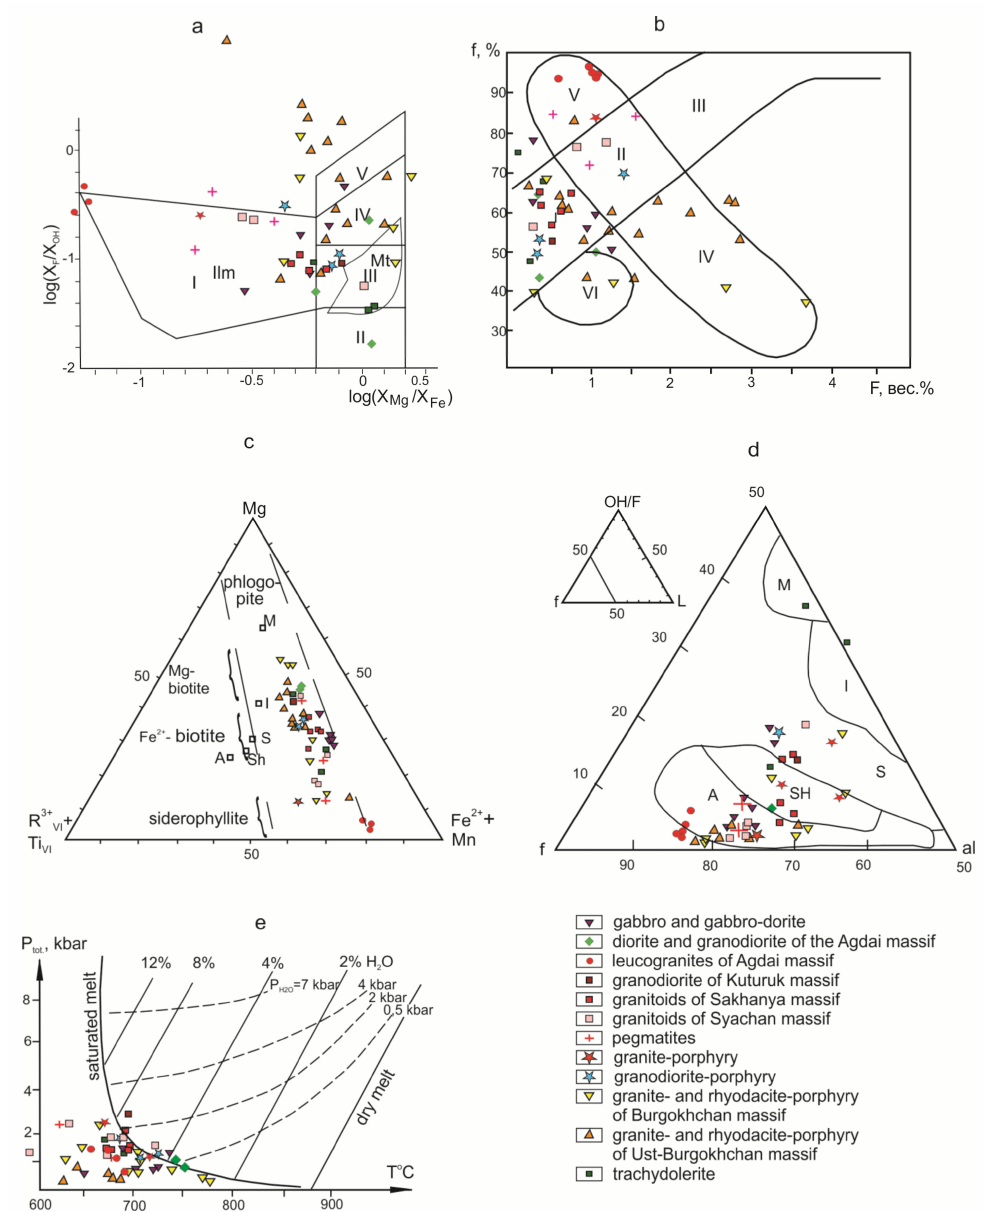
Figure 4. Composition of biotites from magmatic rocks of the Selennyakh River basin: ( a ) F/OH– Mg/Fe diagram for biotites of magmatic rocks. Fields of biotite derived from melts [28]: I— contaminated and assimilated marine metasediments; II—mantle; III—crustal-mantle; IV—mantle- crustal; V—crustal anatectic; Ilm—ilmenite series of granitoids, Mt—magnetite series of grani- toids; ( b ) F vs. f diagram for biotites. Fields of the diagram [29]: I–II–III—biotites from rocks of granite-leucogranite and granodiorite-granite associations; IV–II–V—gabbro-granite